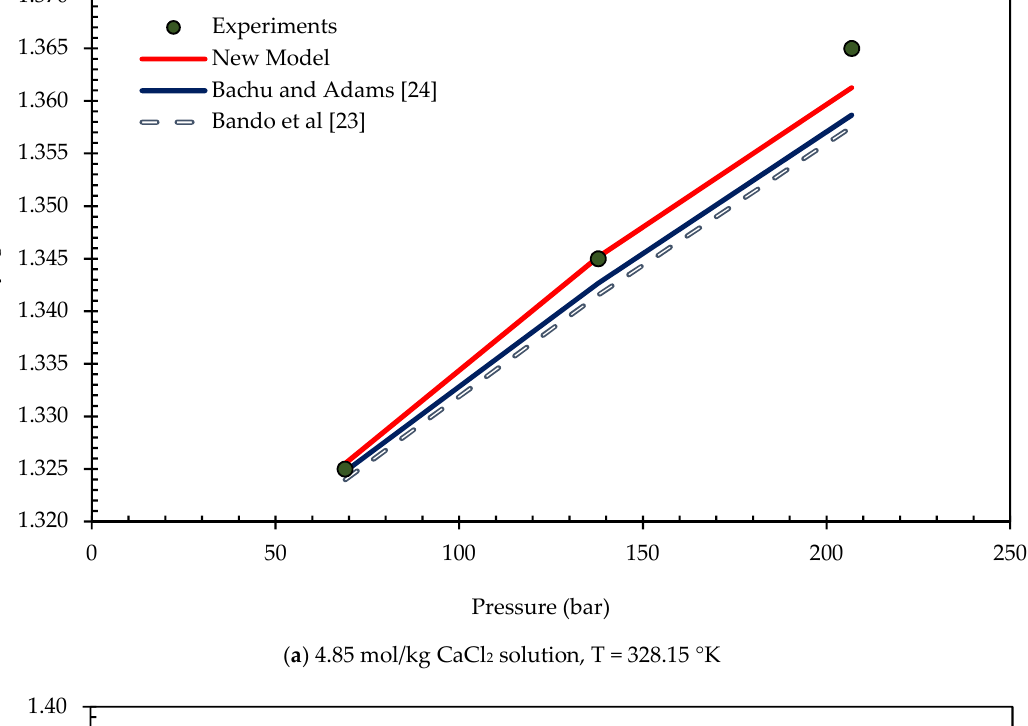
Figure 9. A comparison of experimentally measured and different model estimations for density of a 1.91 mol/kg-CaCl 2 solution saturated with CO 2 at ( a ) 328.15 °K and ( b ) 375.15 °K.